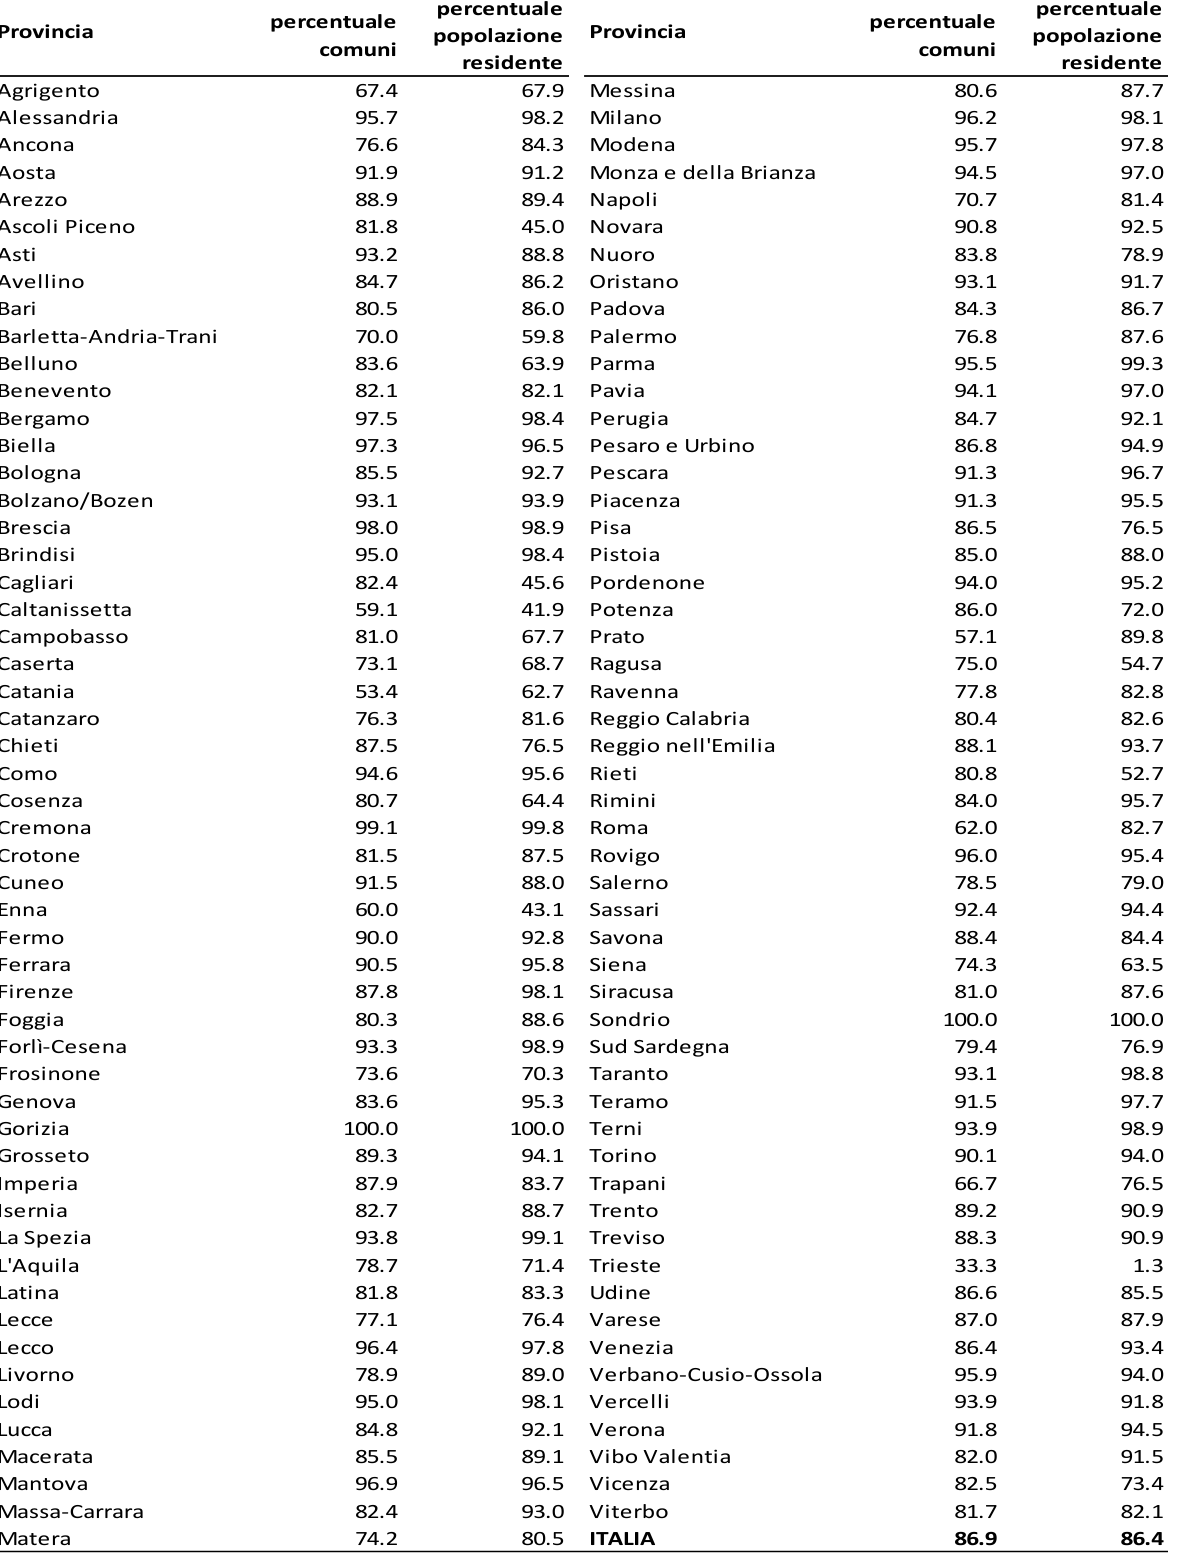
Tabella A1. Copertura provinciale per comune e popolazione residente dei 6.866 comuni diffusi